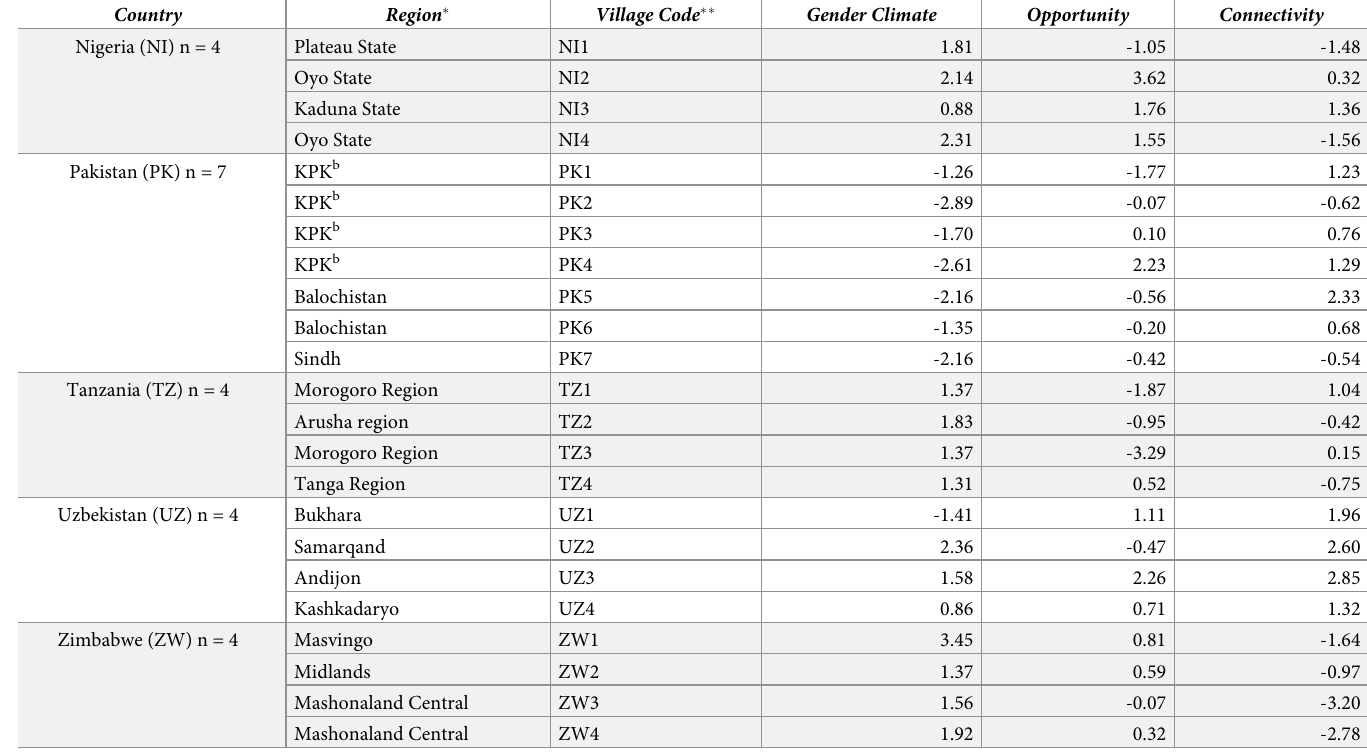
relatively more relaxed GC (Fig 3). Most country cohorts appeared rather homogeneous in terms of GC, either in positive (relaxed) or negative (restrictive) ways. For instance, the Ban- gladesh cohort reported restrictive GC across the 6 villages surveyed (average GC = -1.95, sd = 0.23) whereas the Tanzania cohort exhibited a relatively relaxed GC across the 4 villages part of the study (average 1.47, sd =